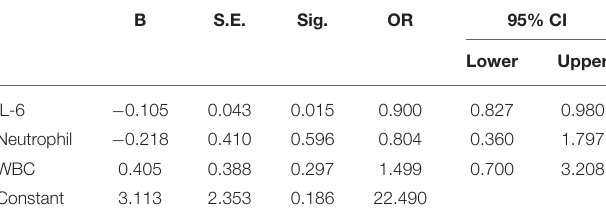
TABLE 2 | Binary logistic regression models for SERPINA3.